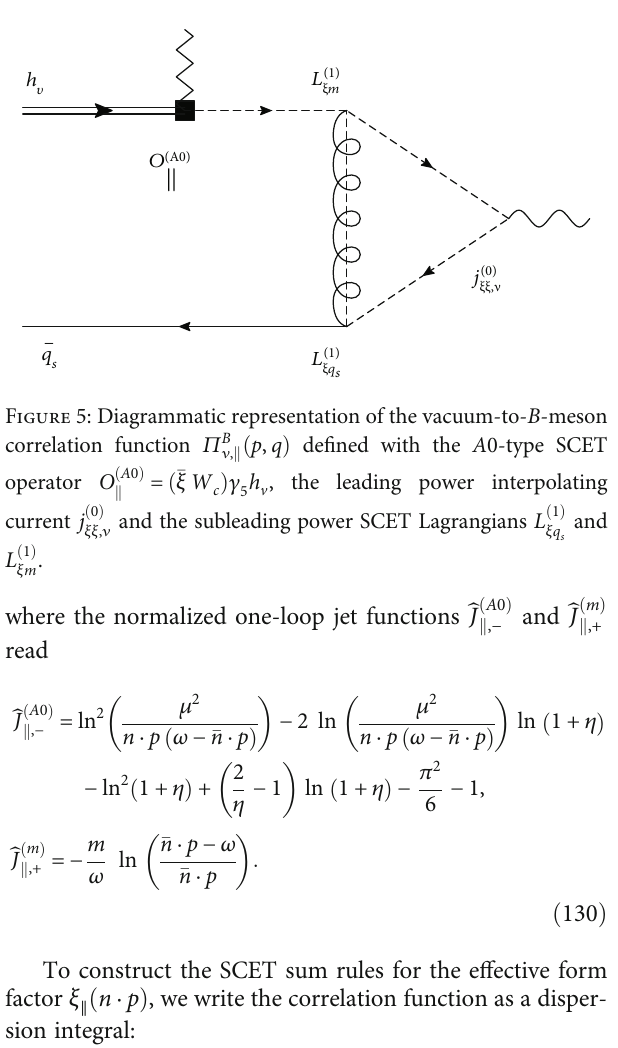
, and the subleading power SCET Lagrangian L ð 2 Þ ξ , ν